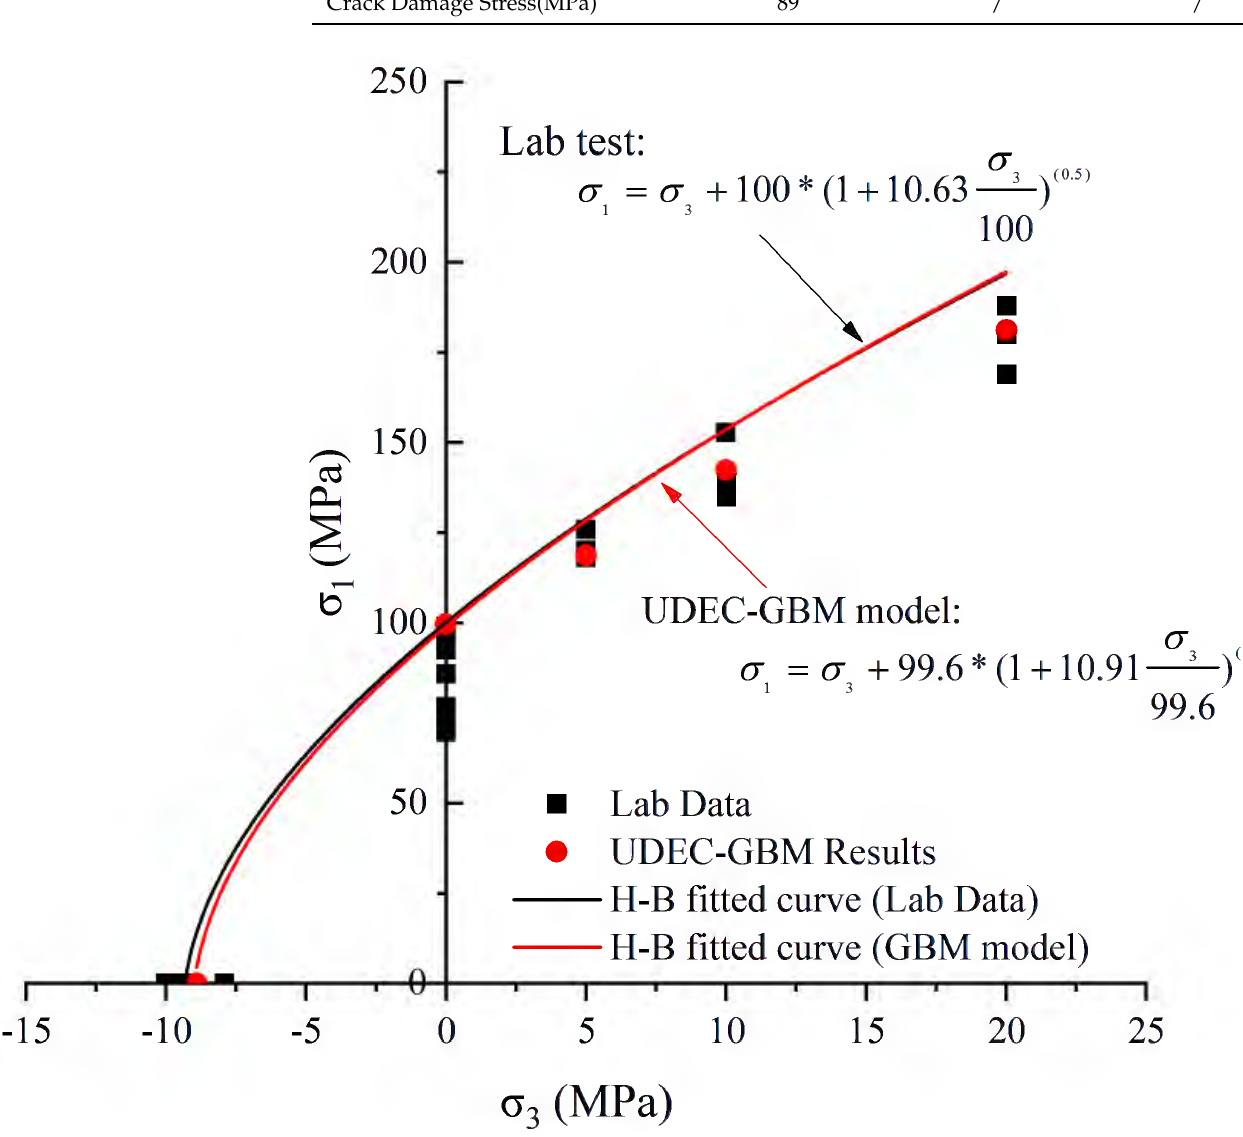
Figure 7. Hoek–Brown curve was compared between simulated strength curve and laboratory